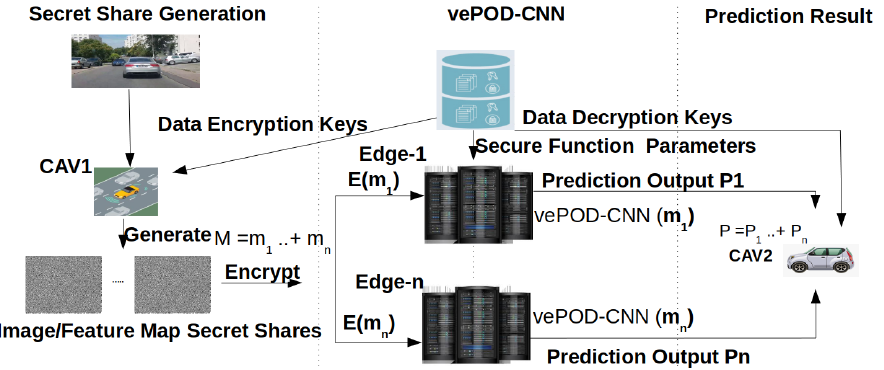
Figure 1. Workflow of vePOD: vehicle–edge collaborative deep learning with privacy preservation for object